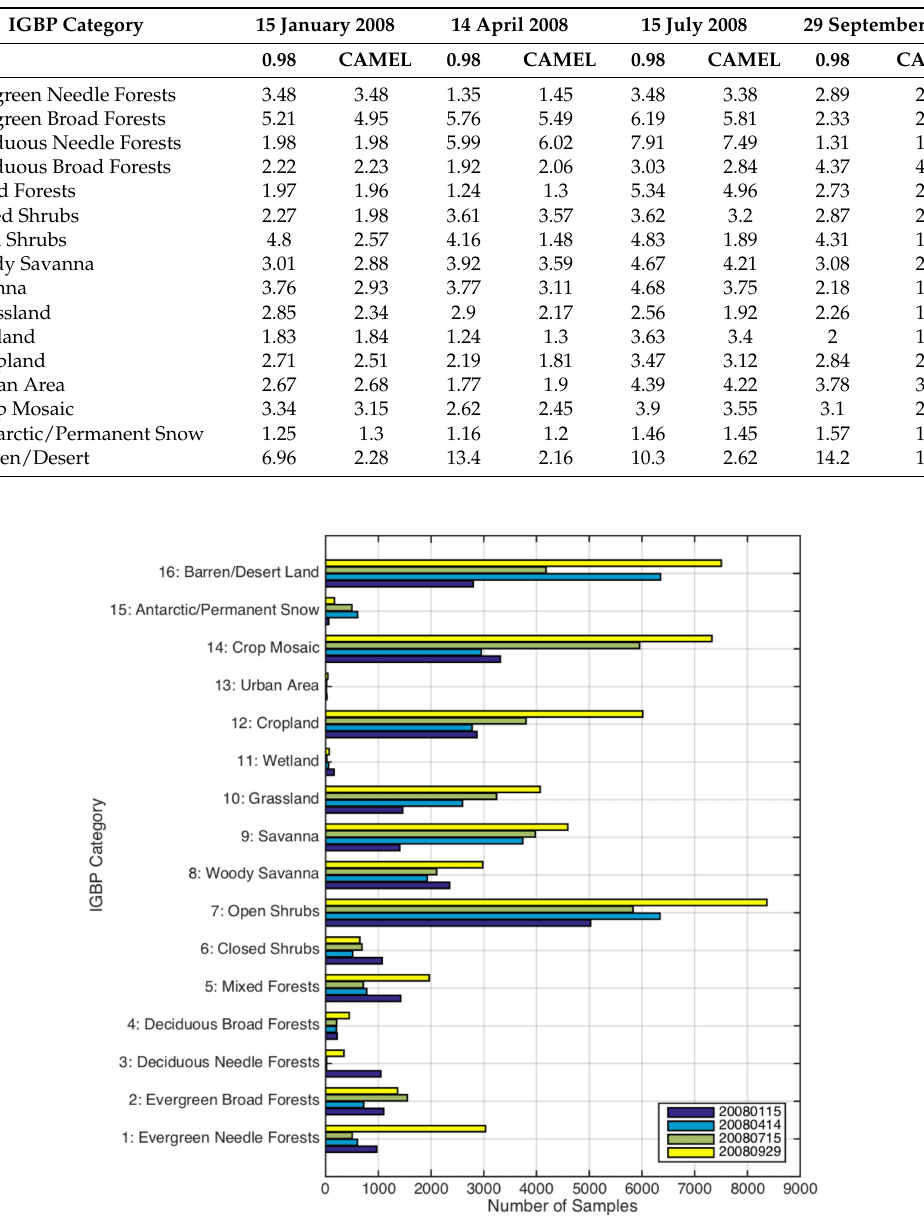
Table 4. Variance over the 8–9 µ m region of de-biased IASI calculated minus observed BTs are averaged by IGBP land classification categories for four focus days and shown below in units of Kelvin for nighttime cases. De-biased variances for BTs calculated using a constant 0.98 emissivity and the CAMEL HSR emissivity module are shown. The corresponding number of samples are shown in Figure 10.